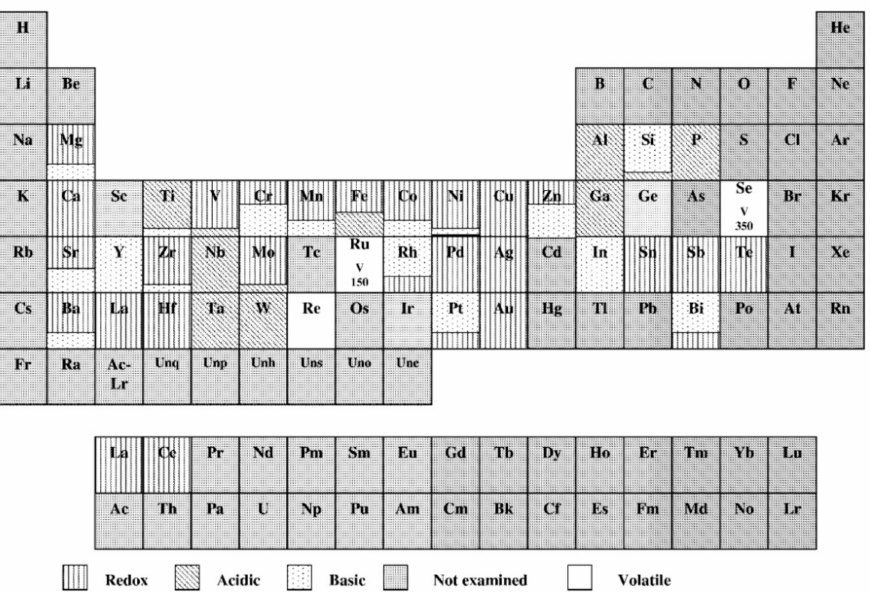
Figure 45. MeOH oxidation selectivity over the pure oxide catalysts. Redox = FA, MF, and DMM; Acidic = DME; basic = CO 2 . Reprinted by permission from [231] Plenum Publishing Corporation, Catalysis Letters, Copyright © (2001).